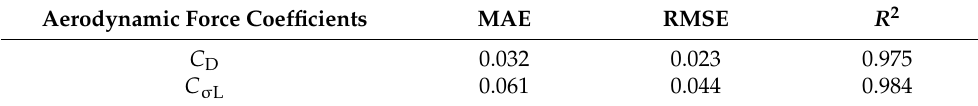
Table 2. Calculated values of performance indicators of the GA-GRNN surrogate model.